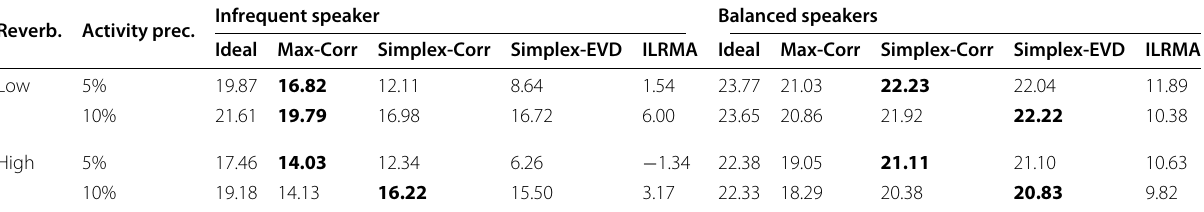
Table 2 Distributed array: SIR scores—mixtures with unbalanced activity for “Low”/“High” reverberation and for “5%”/“10%” activity of the 1st speaker Infrequent Reverb. Activity prec.